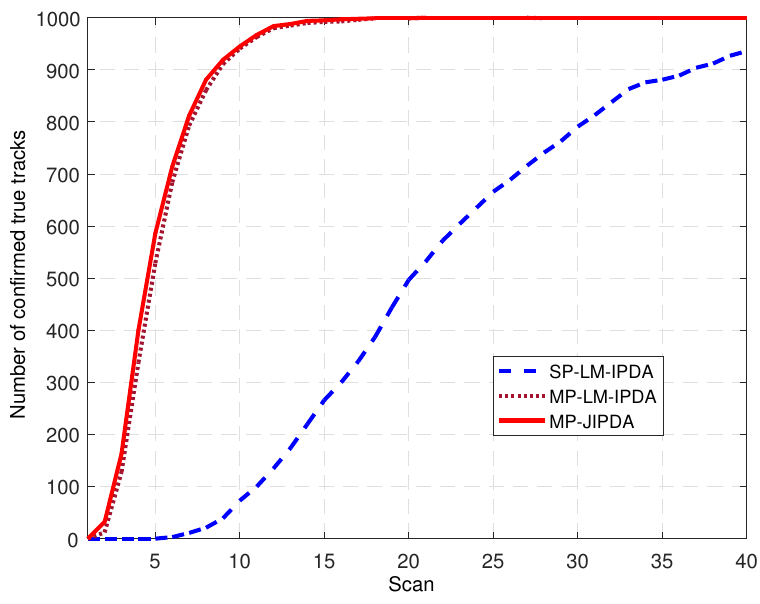
Figure 4. Number of confirmed true tracks for all targets.